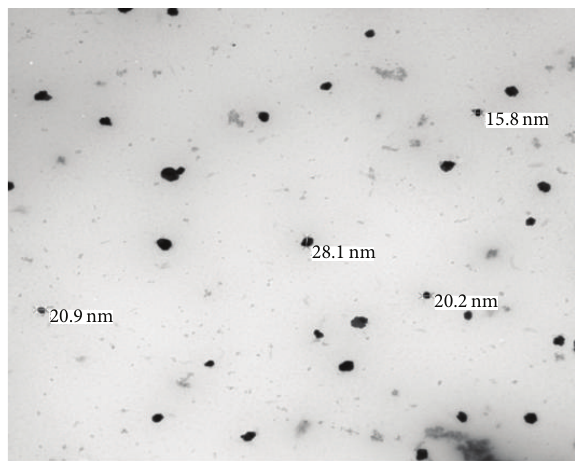
Figure 4: TEM image of prepared nanozirconium